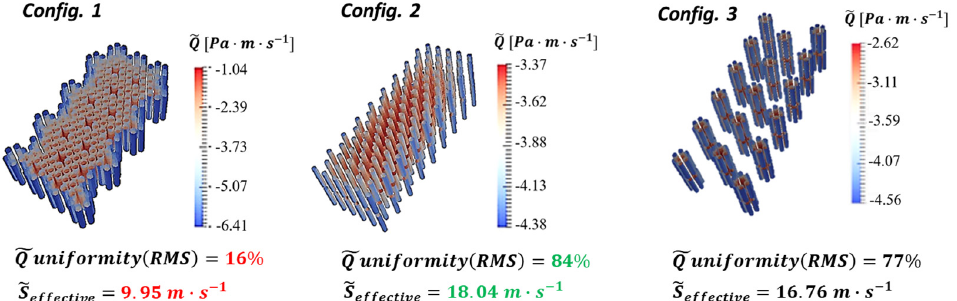
Figure 3. Simulated gas uniformity of the three investigated configurations.